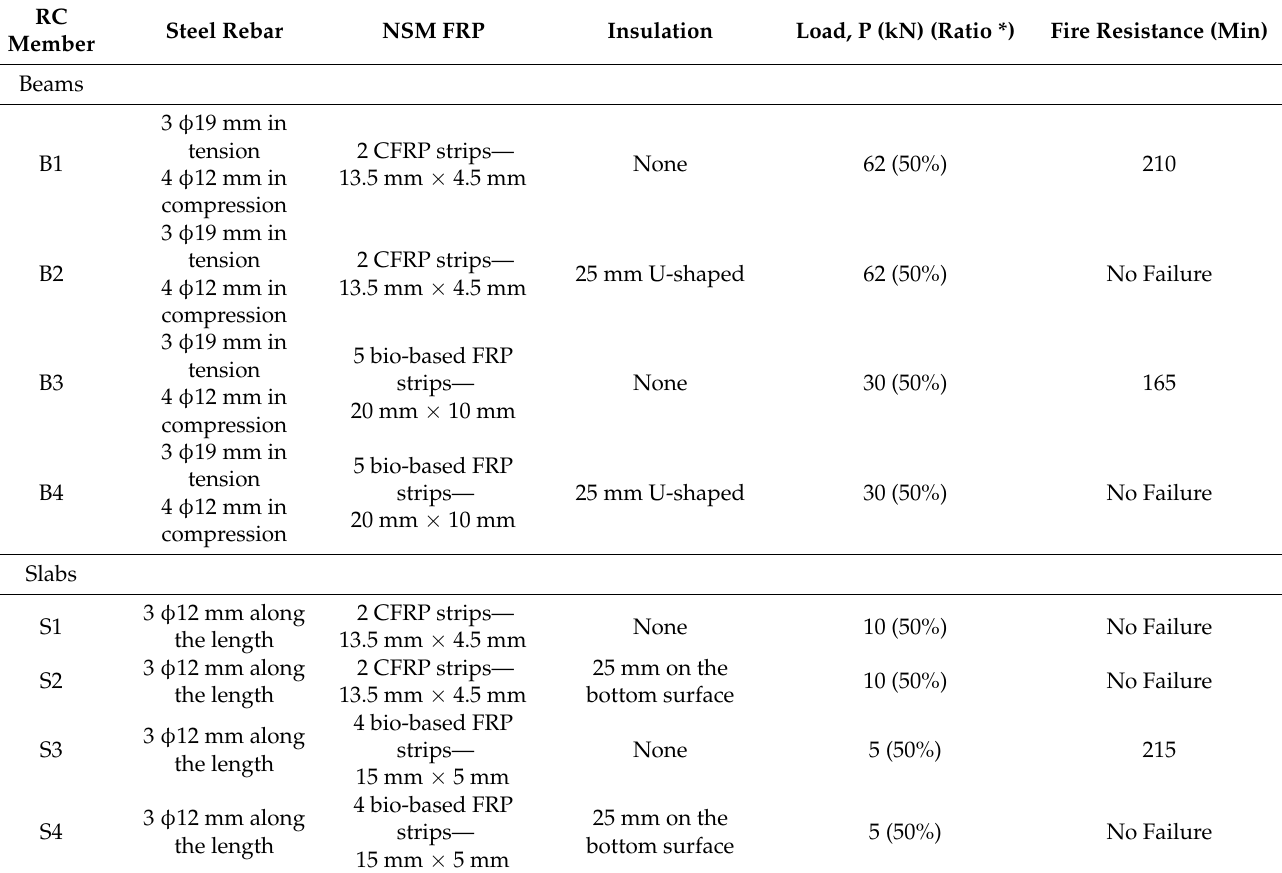
Figure 4. Layout and geometric details of RC members strengthened with EB-type FRP reinforcement. ( a ) RC T-beam strengthened with EB FRP reinforcement; ( b ) RC slab strengthened with EB FRP reinforcement. Table 2. Details of RC beams and slabs with NSM FRP